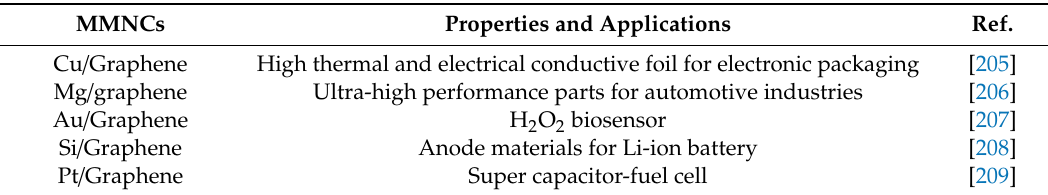
Table 10. An overview of the potential application of MMNCs reinforced by graphene. MMNCs Properties and Applications Ref. Cu / Graphene High thermal and electrical conductive foil for electronic